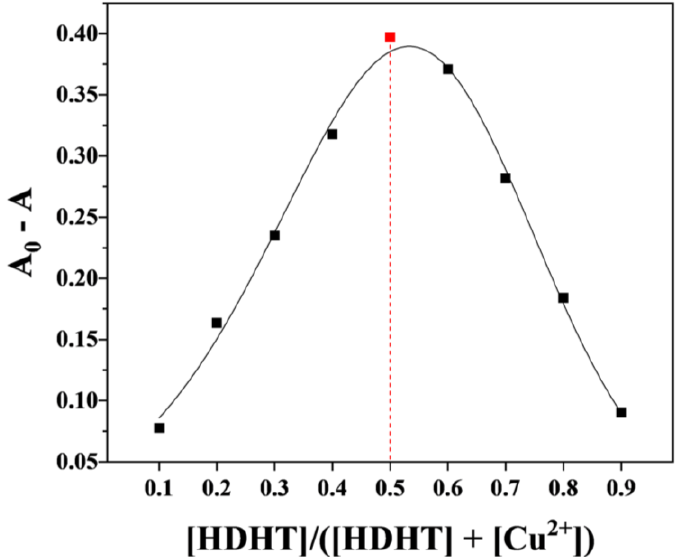
Figure 3. Job-plot analysis for determining the stoichiometry of HDHT and Cu 2+ at 430 nm (red line: ([ HDHT ]/[ HDHT ]+[Cu 2+ ]) = 0.5).